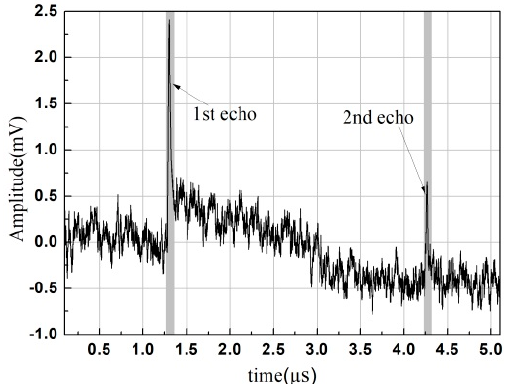
Figure 5. Laser-generated ultrasound waveform measured for α -titanium alloy annealed at 800 ◦ C holding for 1